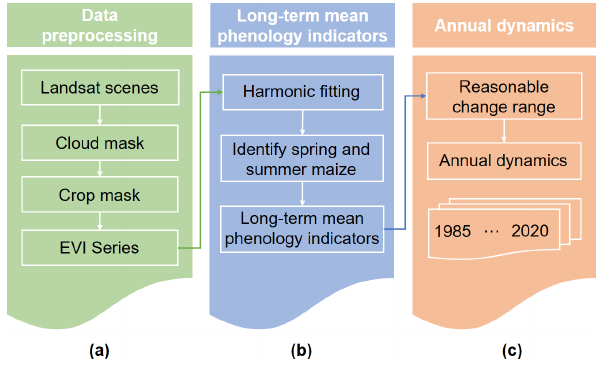
Figure 3. The adopted framework for deriving annual phenology dynamics (1985–2020) from Landsat time series data, including data preprocessing (a) , mapping the long-term mean phenology in- dicators (b) , and identifying the annual dynamics (c)